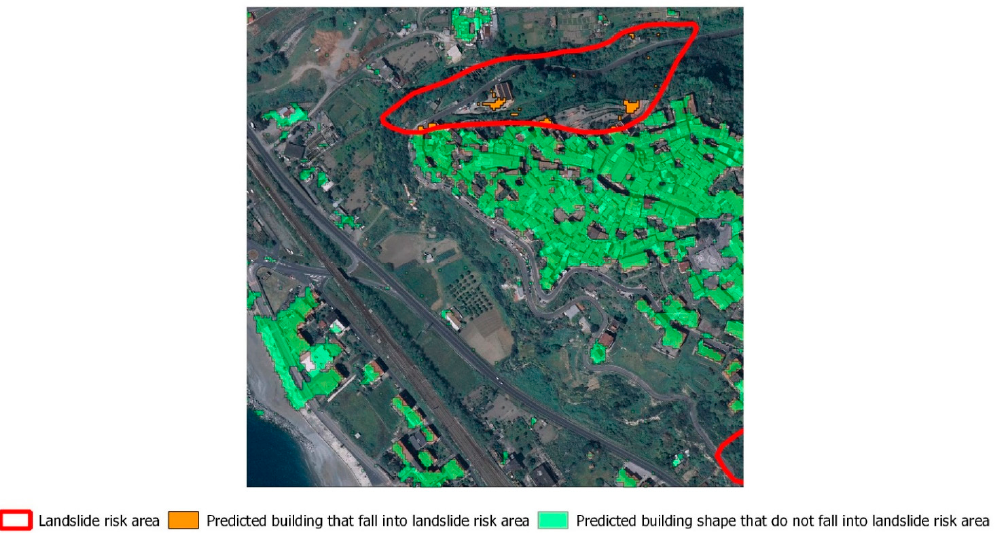
Figure 10. Predicted buildings’ mask and landslide risk zones delimitation in Cetraro, represented in QGIS environment.